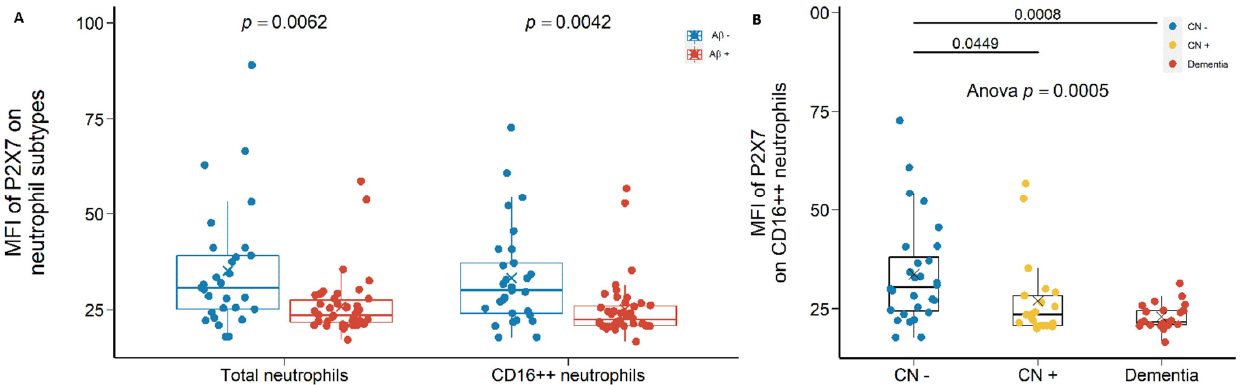
Figure 3. P2X7 expressions on neutrophils in the discovery cohort. ( A ) P2X7 expressions on total neutrophils ( left ) and CD14 − CD16 ++ neutrophils ( right ) between in Aβ −ve controls (Aβ−) and Aβ +ve cases (Aβ+). Bar graphs illustrated the boxplot distribution of individual measurements with “x” denoting the mean. Two group comparison was determined by t -test. ( B ) P2X7 expressions on CD14 - CD16 ++ neutrophils between CN (CN−: CN −ve), pre-clinical (CN+: CN +ve), and AD with dementia (Dementia: MCI +ve and AD) individuals. Bar graphs illustrated the boxplot distribution of individ- ual measurements with “x” denoting the mean. Three-group comparison was determined by one-way ANOVA followed by multiple comparison using Dunnett’s post-hoc test (solid line).